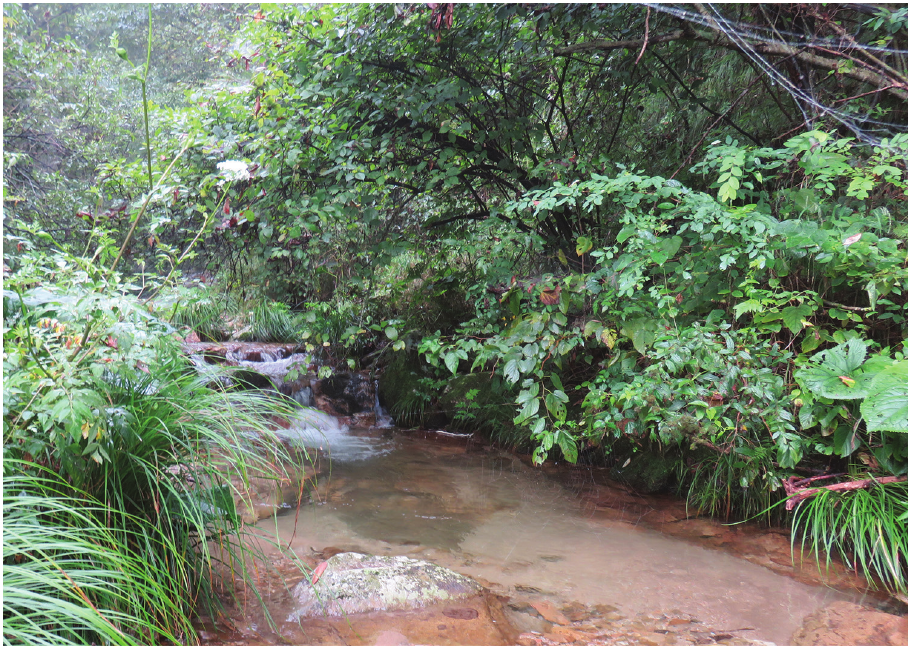
Figure 5. Typical habitat of Rana dabieshanensis sp. n. in Dabie Mountains, Anhui Province, China. INS 2.7–4.7 mm N=20), R. jiemuxiensis (IOS 4.3–7.5 mm, INS 2.5–3.8 mm); internarial distances larger than interorbital distances of in R. maoershanensis (IOS 3.1–3.3 mm,